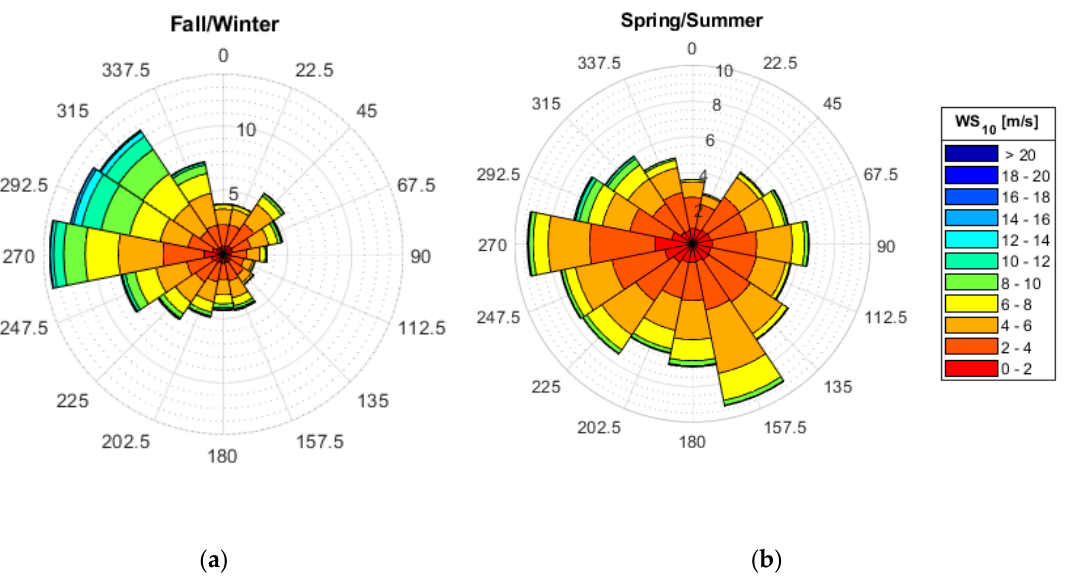
Figure 2. Seasonal wind roses for winter ( a ) and summer ( b ) at Sandy Hook (NOAA 8531680).